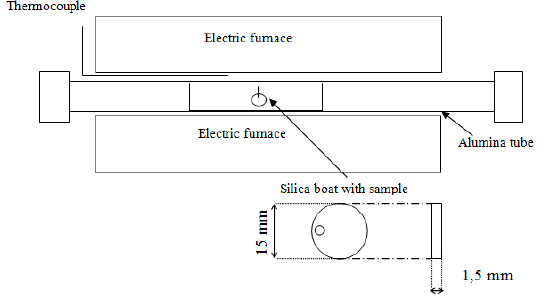
Figure 1. Experimental test rig and sample used in oxidation expo- sure of TiAlCrY coated Ti45Al8Nb alloy between 750 ◦ C - 950 ◦ C for 500 hours